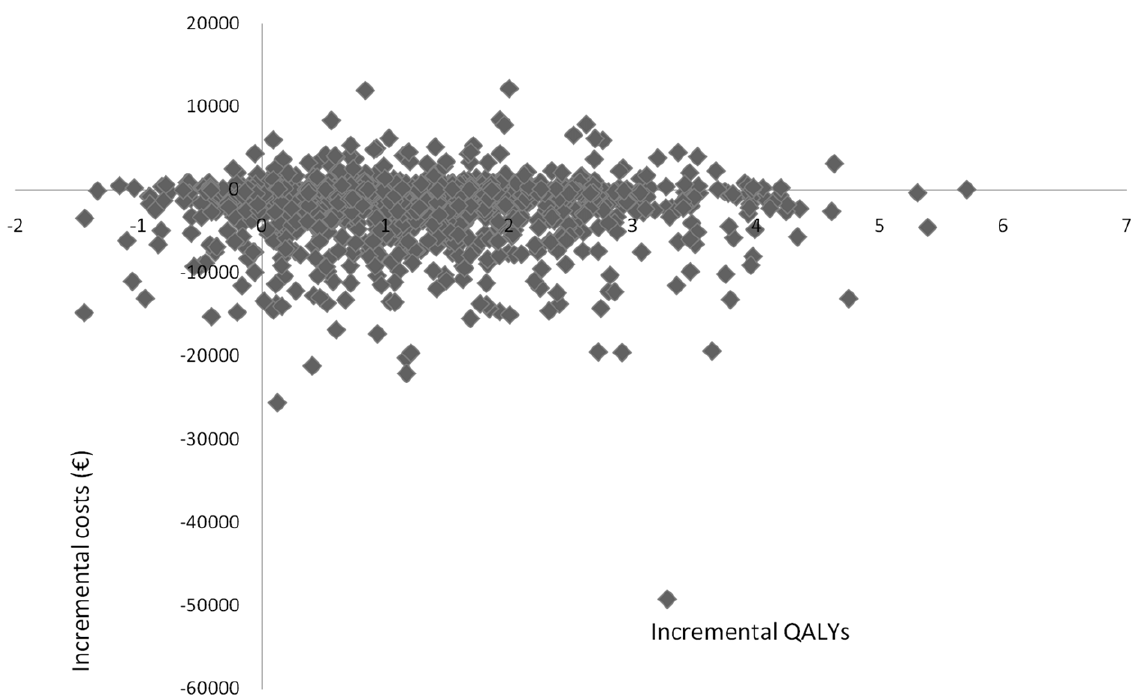
Figure 3. Cost-effectiveness plane showing 1000 replications from a distribution of cost and quality-adjusted life year (QALY) differences (angiotensin converting enzyme inhibitor vs microalbuminuria screening).